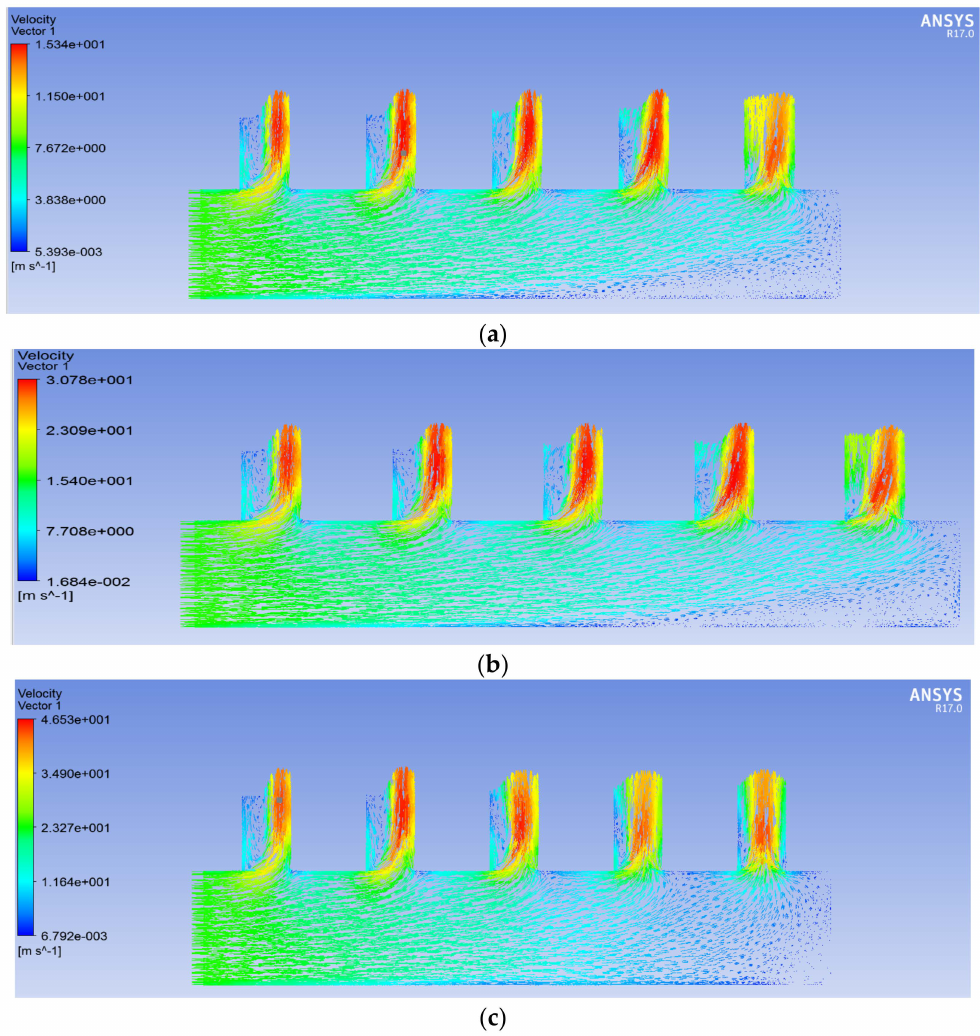
Figure 11. The velocity flow field distribution of different rice distributor CFD simulation with type A. ( a ) 8 m/s inlet velocity; ( b ) 16 m/s inlet velocity; ( c ) 24 m/s inlet velocity.